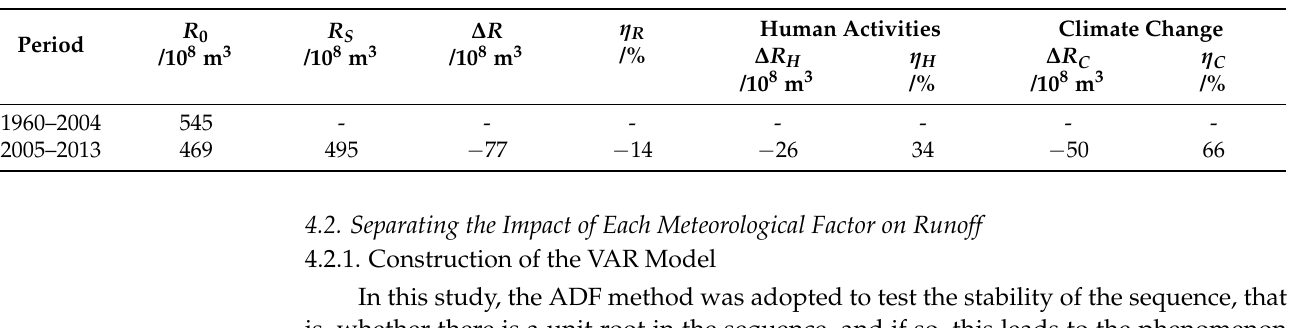
Figure 7. Results for the runoff simulation of the CHSH model. Table 3. Impact of climate change and human activities on runoff based on the CHSH